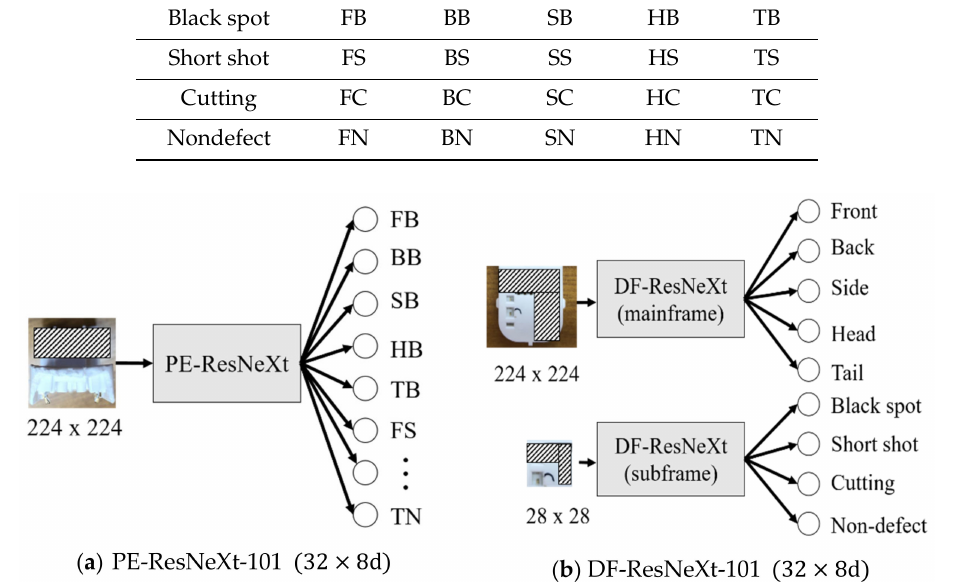
Figure 9. DK-ResNeXt used for the case study.